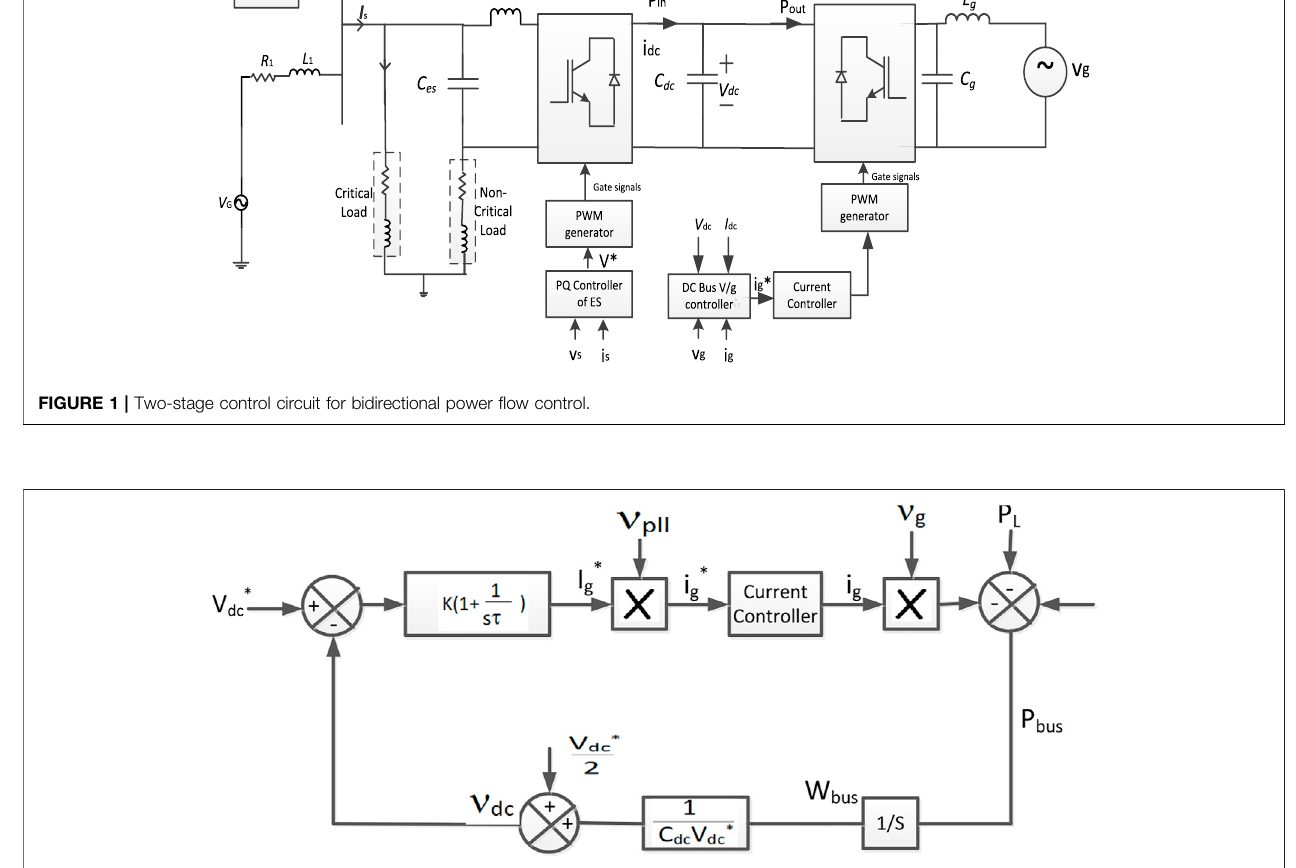
FIGURE 2 | DC link voltage control loop with current